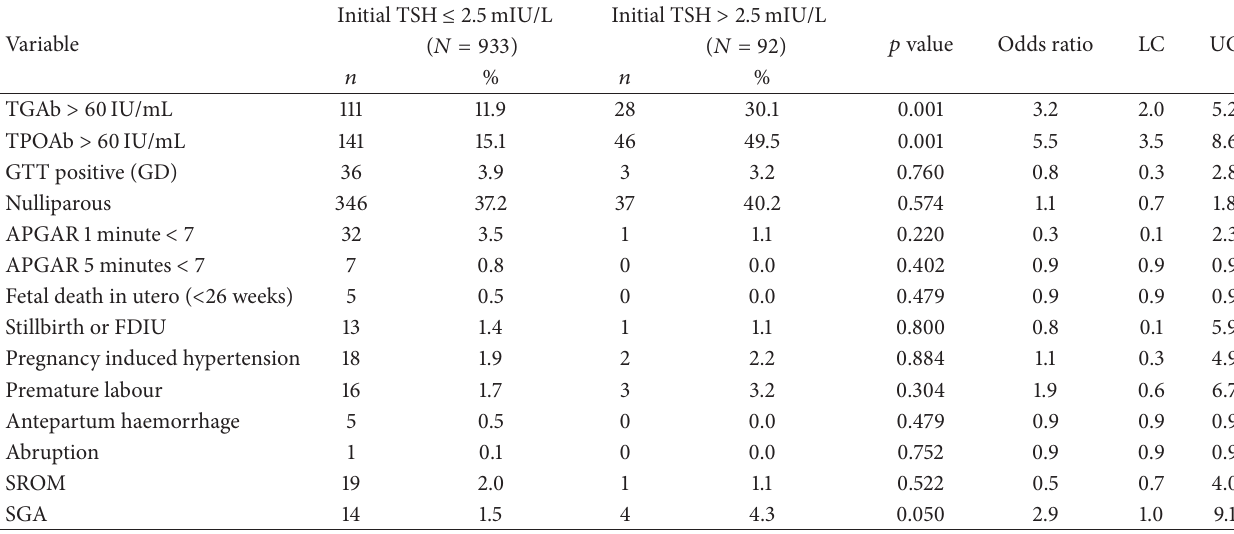
Table 1: A comparison of pregnancy outcomes in patients with initial serum TSH ≤ 2.5 mIU/L ( 𝑛 = 933 ) and those with serum TSH > 2.5 mIU/L who were treated with thyroxine ( 𝑛 = 92